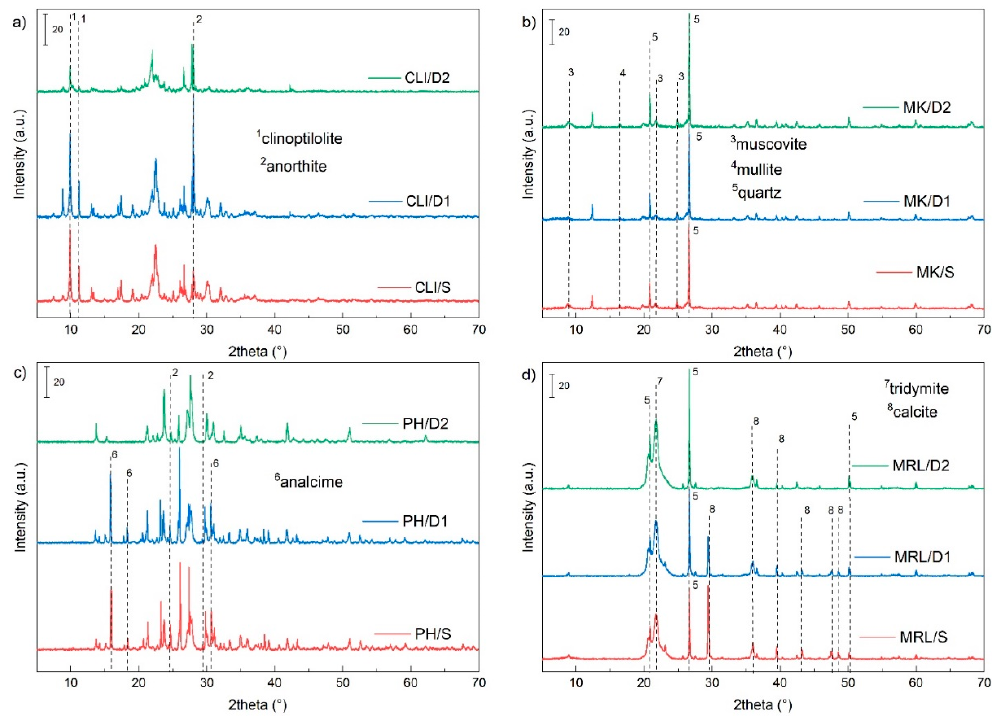
Figure 2. XRD pattern of clinoptilolite ( a ), metakaolin ( b ), phonolite ( c ) and marlstone ( d ).